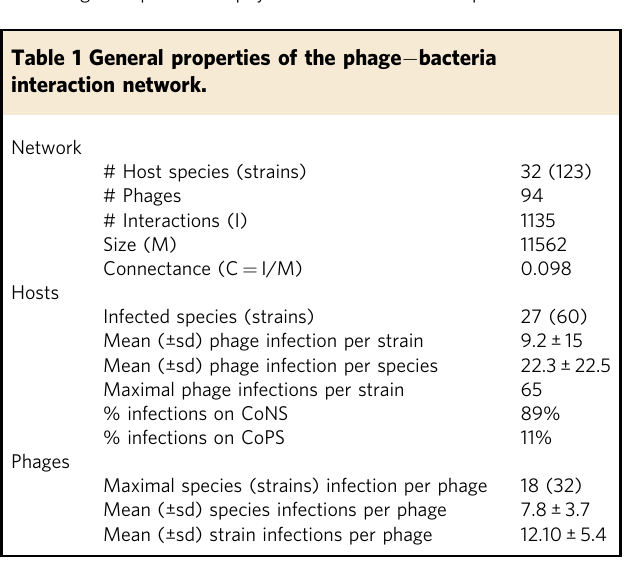
Fig. 2 Phage infections on staphylococcal species. Species challenged in the phage-bacteria interaction matrix are shown on the x -axis and sorted after the established Staphylococcus species groups 13 . a For each species, the number of phage resistant and susceptible strains are depicted. b Phage infections on each respective species were plotted as a percentage of the total infections detected in the interaction matrix. CoNS coagulase-negative staphylococci,